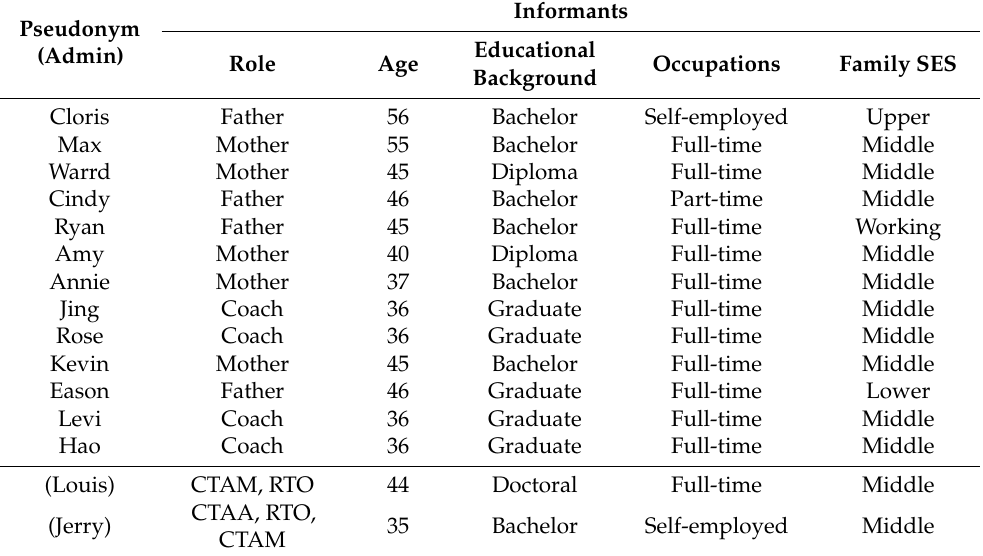
Table 2. Demographic Information of Informants ( n =